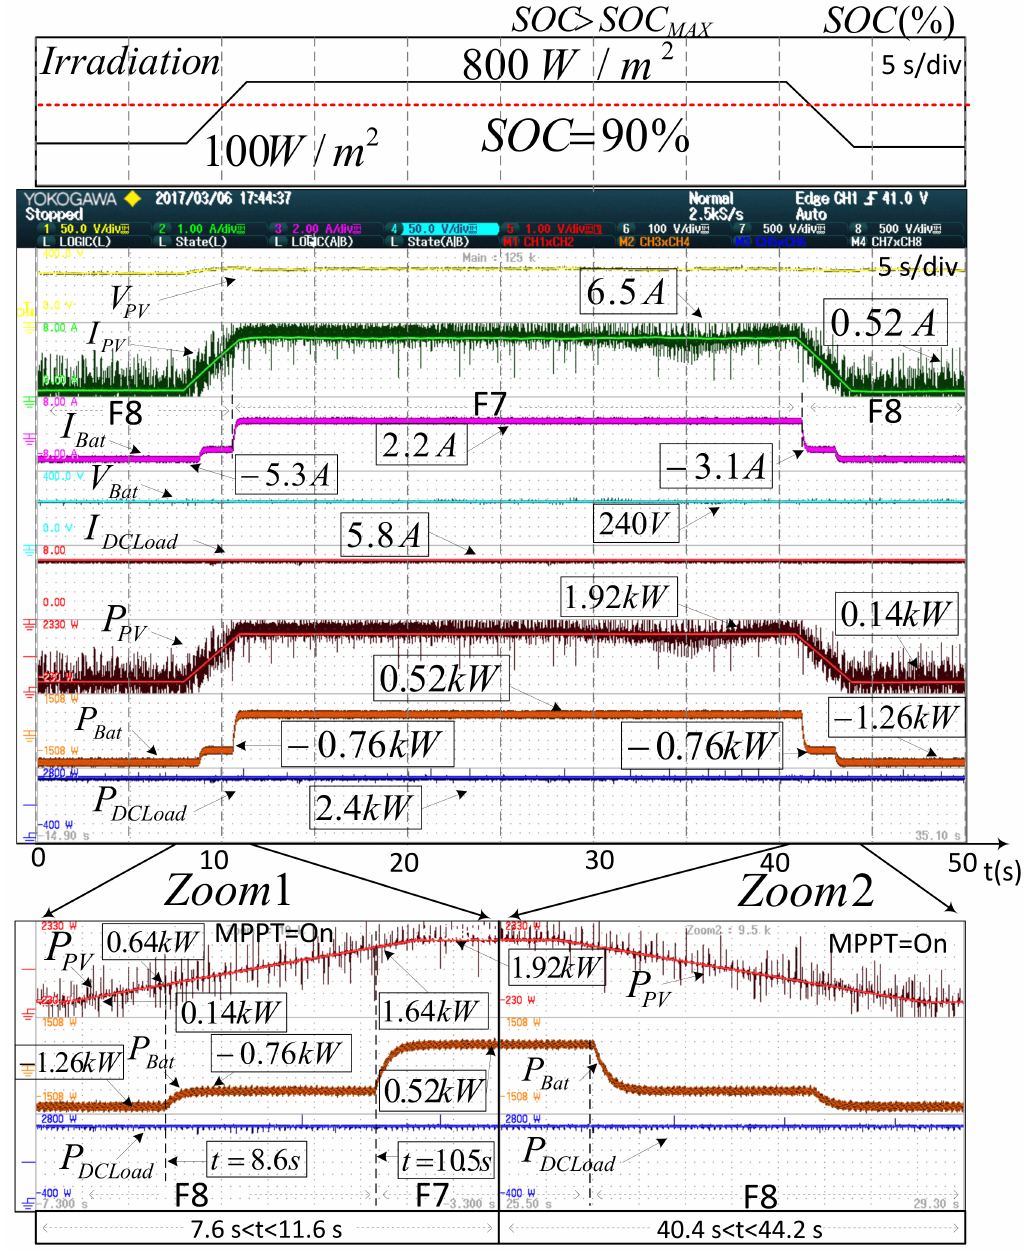
Figure 10. Experiment